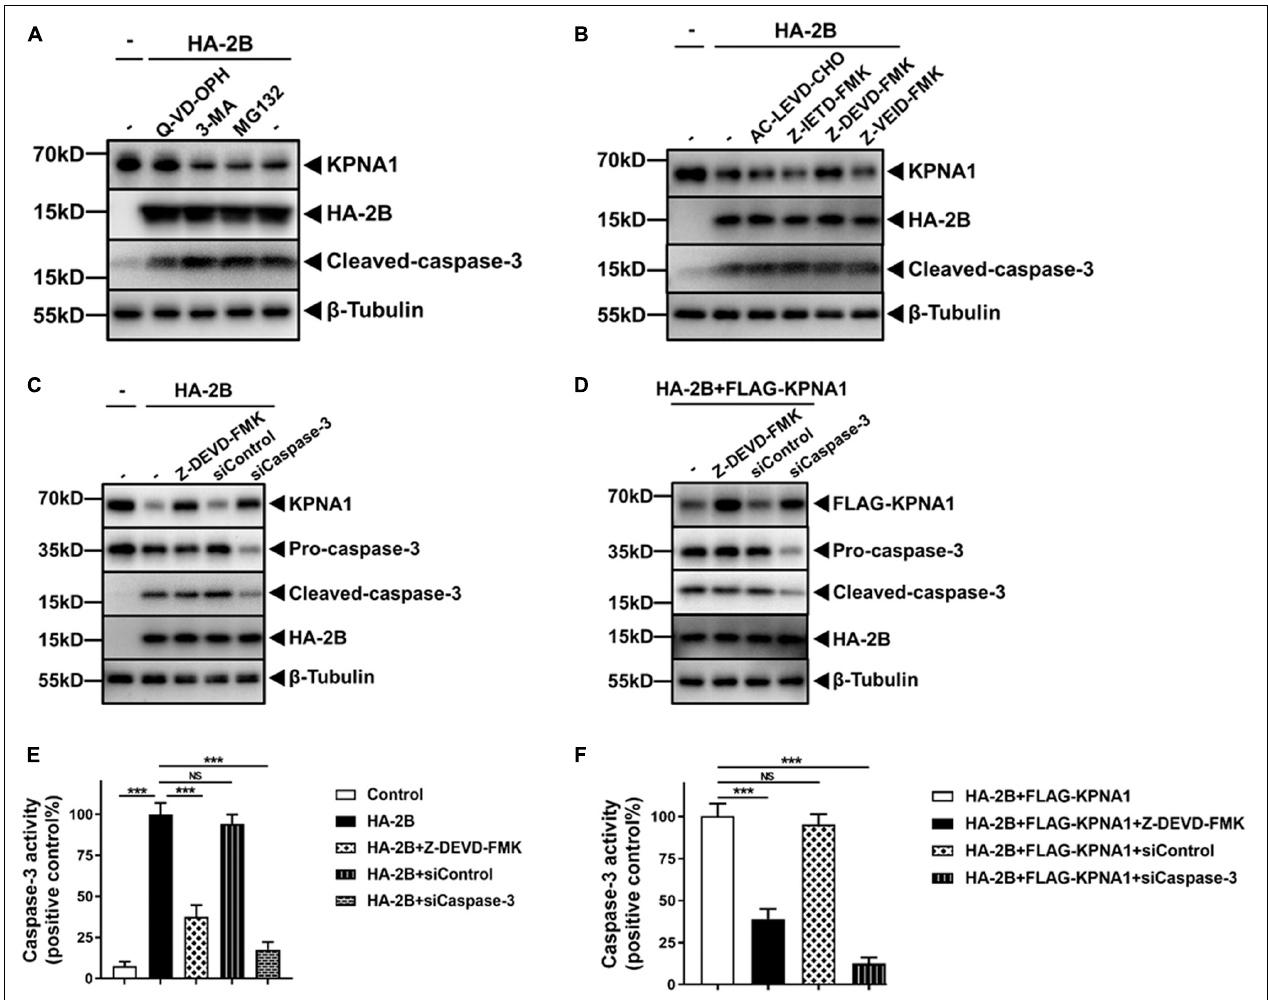
FIGURE 4 | Caspase-3 was involved in KPNA1 degradation induced by 2B. (A) Degradation of KPNA1 was prevented from degradation by a caspase inhibitor. HeLa cells were pre-treated with a broad-spectrum caspase inhibitor, Q-VD-OPH (20 nM), an autophagy inhibitor, 3-MA (10 mM), or a proteasome inhibitor, MG132 (5 µ M), for 12 h, followed by transfection with plasmids expressing HA-tagged 2B (2.0 µ g) for another 36 h. The whole cell lysates were prepared for western blot analyses with antibodies specific for KPNA1, HA tag, and cleaved-caspase-3. (B) A caspase-3 specific inhibitor prevented KPNA1 from degradation. HeLa cells were pre-treated with inhibitors specific for caspase-4 (AC-LEVD-CHO, 30 µ M), caspase-8 (Z-IETD-FMK, 30 µ M), caspase-3 (Z-DEVD-FMK, 100 µ M), and caspase-6 (Z-VEID-FMK, 50 µ M) for 12 h prior to transfection with HA-2B plasmid (2.0 µ g). The whole cell lysates were prepared 36 h post transfection for western blot analyses with antibodies for KPNA1, HA tag, and cleaved caspase-3. (C,D) Degradation of KPNA1 was caspase-3 dependent. HeLa cells were transfected with siRNA specific for caspase-3, or a scramble RNA as control (siRNA final, 50 nM), or pre-treated with an inhibitor specific for caspase-3 (Z-DEVD-FMK, 100 µ M), for 24 h, followed by transfection of plasmids expressing HA-tagged 2B alone (C) or by co-transfection of plasmids expressing HA-tagged 2B and FLAG-tagged KPNA1 (D) for another 36 h. Cell lysates were prepared for western blot analyses with antibodies for KPNA1, HA tag, pro-caspase-3, or cleaved-caspase-3. Degradation of endogenous and exogenous KPNA1 was shown in panels (C,D) , respectively. (E,F) Relative caspase-3 enzymatic activities were detected in cells expressing 2B. Cell lysates were prepared from the cells with different treatments for the caspase-3 activity assay. The cells were either transfected with plasmids to expressing HA-2B alone (E) or co-transfected with plasmids to expressing HA-2B and KPNA1 (F) . The values represented mean ± SD from triplicates of independent experiments. Cells transfected with HA-2B (E) and HA-2B + FLAG-KPNA1 (F) were used as positive controls. Results of t tests were shown as transverse lines as indicated. NS, no significance; *** P <